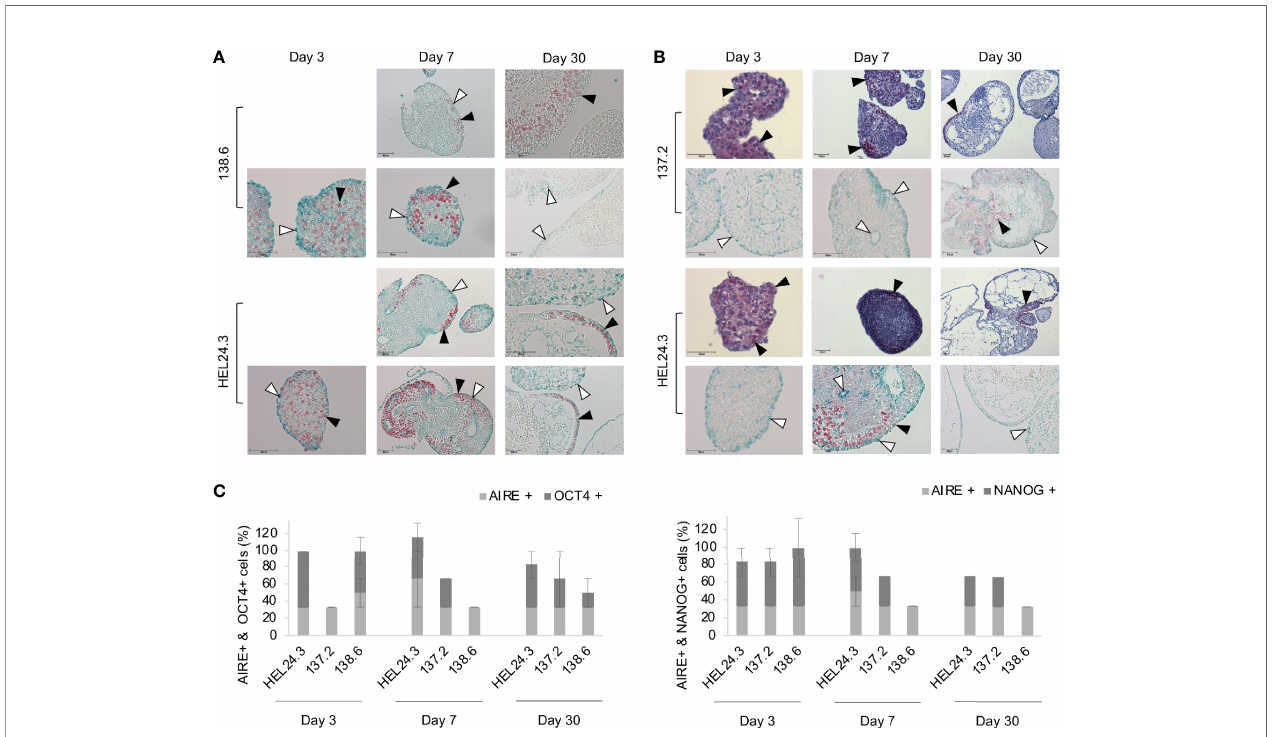
FIGURE 6 | AIRE mutation does not affect the spatial localization of AIRE, OCT4, or NANOG proteins in EBs. Panel (A) AIRE (green staining, indicated with white arrow heads) and OCT4 (red staining, indicated with black arrow heads) protein expression in EBs generated from iPS cells of APECED patient 138.6 and healthy control HEL24.3 on day 3, 7 and 30 after the generation of EBs. Panel (A) images are without Mayer ’ s hematoxylin counterstaining. Panel (B) AIRE (green staining, indicated with white arrow heads) and NANOG (red staining, indicated with black arrow heads) protein expression detected by immunocytochemistry in EBs generated from iPS cells of APECED patient 137.2 and healthy control HEL24.3. FFPE samples collected on days 3, 7 and 30 after the generation. Mayer ’ s hematoxylin (blue) used as a nuclear counterstain on images on the fi rst and third rows. Images on second and fourth row are without Mayer ’ s hematoxylin. Scale bar equals 50 µm. Panel (C) Quanti fi cation of positive cells in AIRE + OCT4 and AIRE + NANOG immunostainings shown in panels (A , B) . Error bars represent